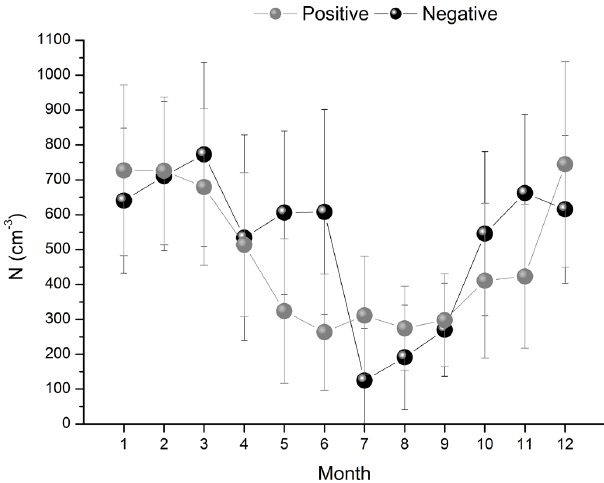
Fig. 1. Annual variability of atmospheric ion concentrations in the size range 0.8–42nm (monthly averages and standard deviation) at Finokalia,